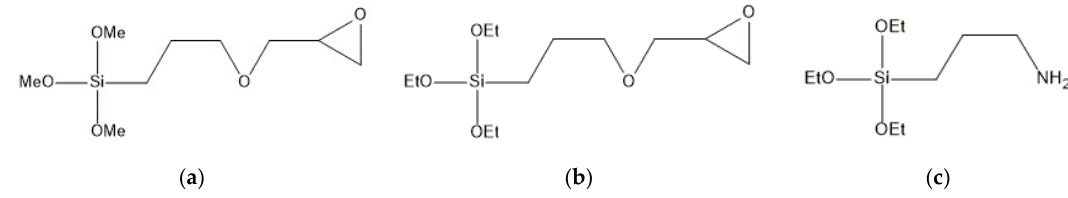
Figure 1. Skeletal structural formulas of the organosilane coupling agents tested in this study: ( a ) 3- glycidyloxypropyltrimethoxysilane; ( b ) 3-glycidyloxypropyltriethoxysilane; and ( c ) 3-